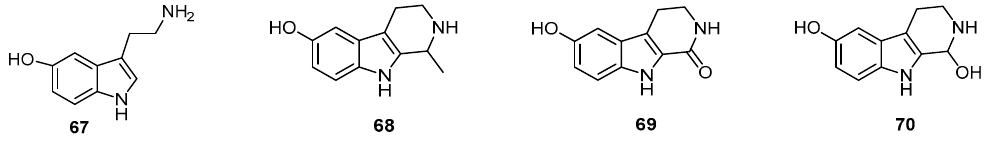
Figure 17. Chemical structures of serotonin ( 67 ) and compounds 68 – 70.